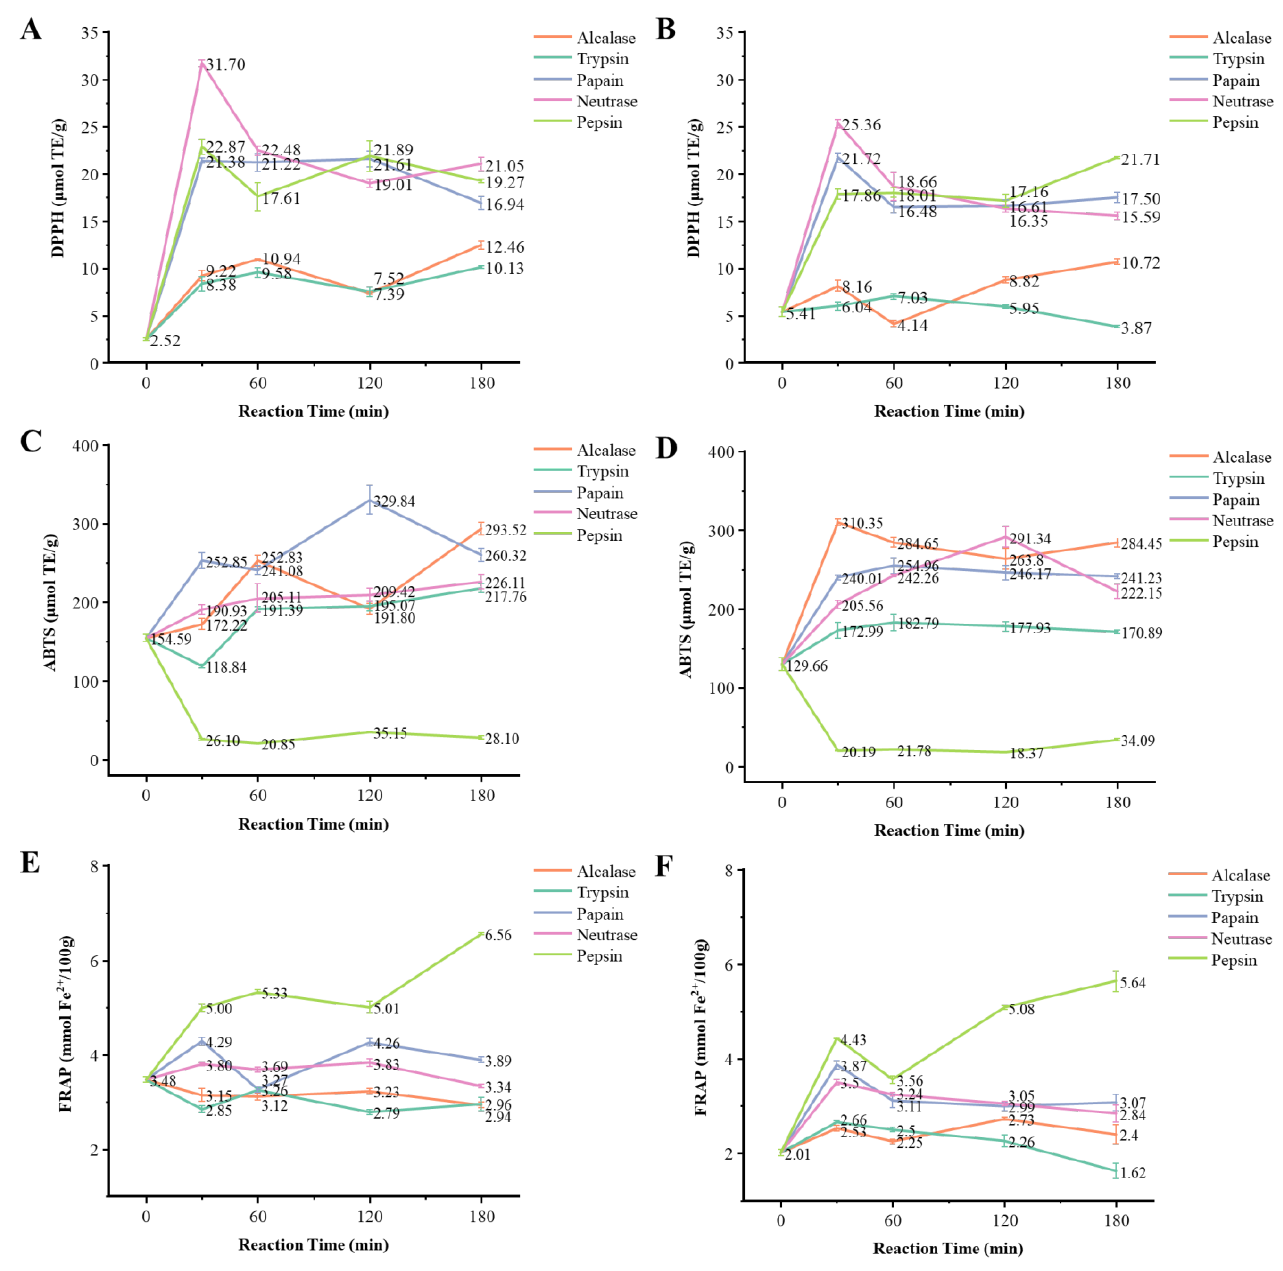
Figure 1. Free radical scavenging capacities of DPPH, ABTS, and FRAP of different Hechong hydrolysates in China and Vietnam group concerning enzymatic hydrolysis time (0 min, 30 min, 60 min, 120 min, and 180 min). The changes in DPPH value, ABTS value, and FRAP value of the China group illustrated in ( A , C , E ). The changes in DPPH value, ABTS value, and FRAP value of the Vietnam group illustrated in ( B , D , F ). Data were expressed as Mean ± S.D. ( n = 3) on a dry weight basis.